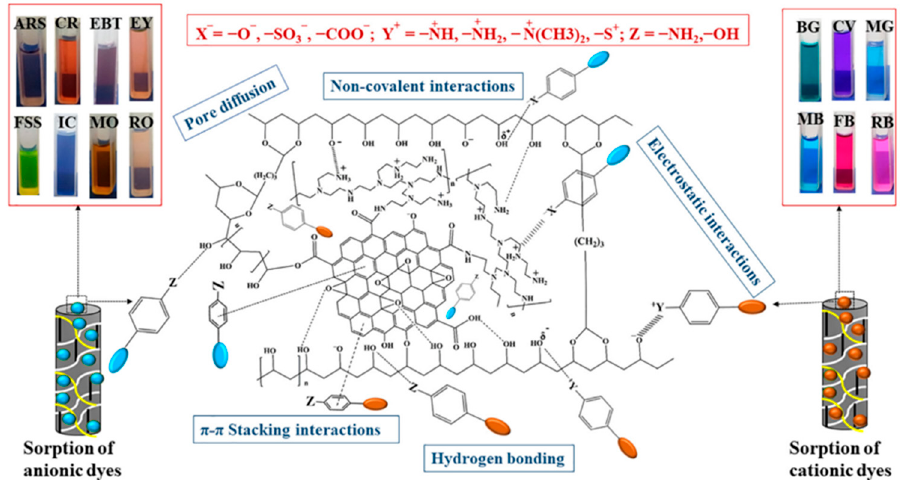
Figure 6. Multi-site dye adsorption mechanism diagram of GPPH microspheres. Reprinted with permission from Reference [89].